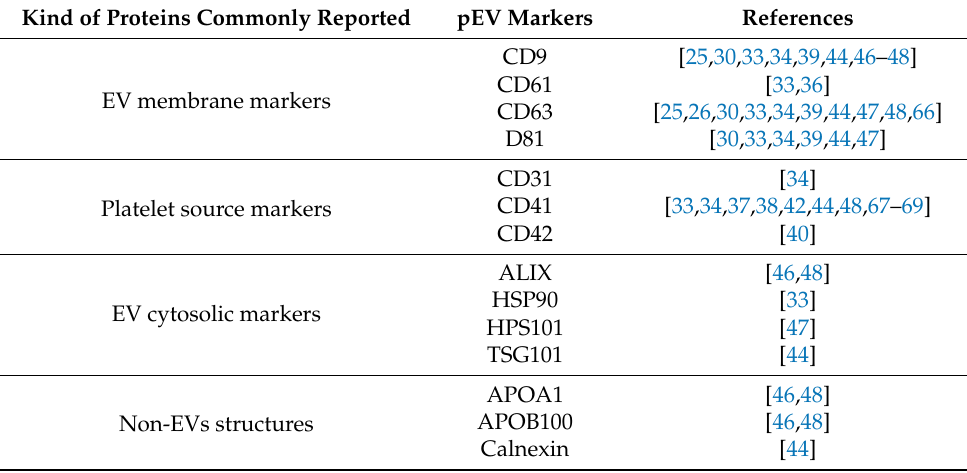
Table 2. Macromolecule characterization reported for pEVs in therapeutical approaches.